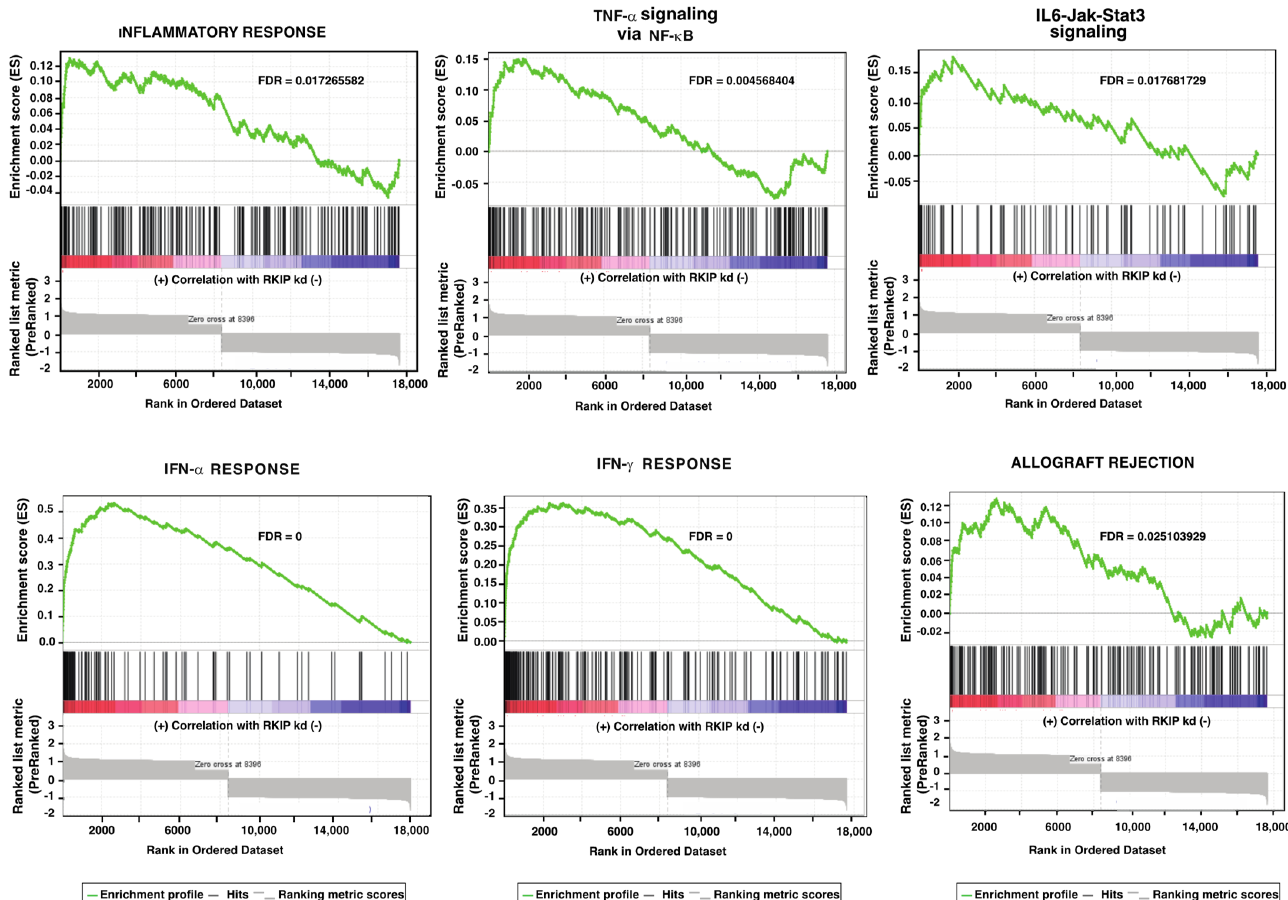
Figure 2. In RKIP knockdown168FARN mouse breast cancer cells, gene sets for immune response were significantly enriched. Enrichment score (ES) are displayed on the y ‐ axis. Vertical black lines on the x ‐ axis represent different genes in the gene sets. Each gene was assigned an ES that was calculated as the maximum deviation from zero as it is going down the ranked list. ES represents the degree of over ‐ representation of a gene set at the top or at the bottom of the ranked gene list. The degree of correlation of genes with the RKIP knockdown are color coded with red for positive and blue for negative correlation. Significance threshold set at FDR < 0.03.